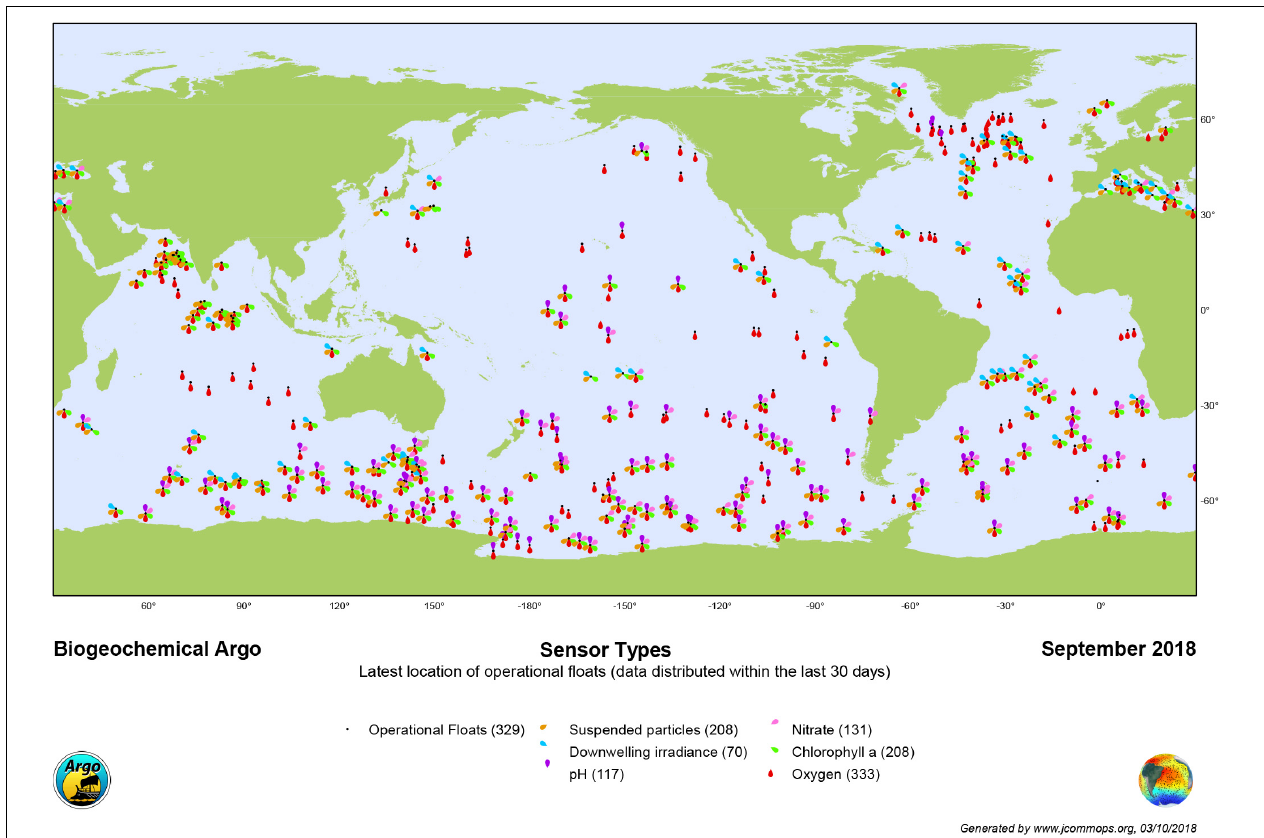
FIGURE 6 | Global map of BGC-Argo floats, indicating sensor types on each float, as of September 2018 (Source: